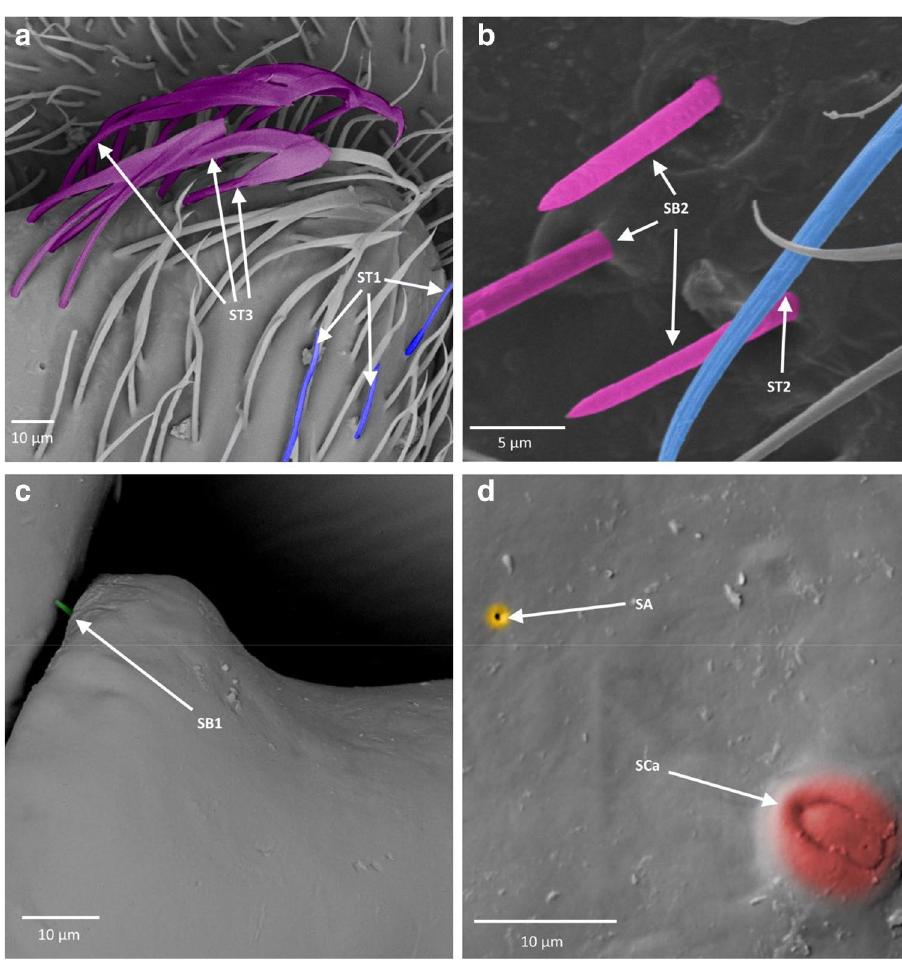
Figure 7. Antennal sensilla; ( a ) Naucoris scutellaris , ( b ) Naucoris cimicoides , ( c ) Pelocoris femoratus , ( d ) Pelocoris poeyi . ST sensilla trichodea, SCa sensilla campaniformia, SB sensilla basiconica